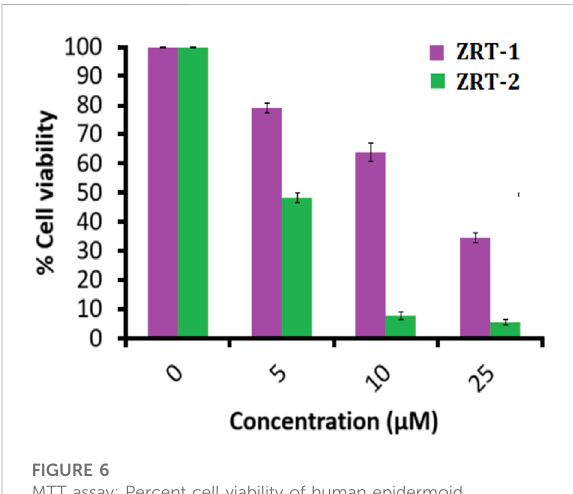
FIGURE 6 MTT assay: Percent cell viability of human epidermoid carcinoma A431cells at24 h.Values areexpressedas mean±SEM of at least three independent experiments, * p < 0.05 as compared with their respective control.